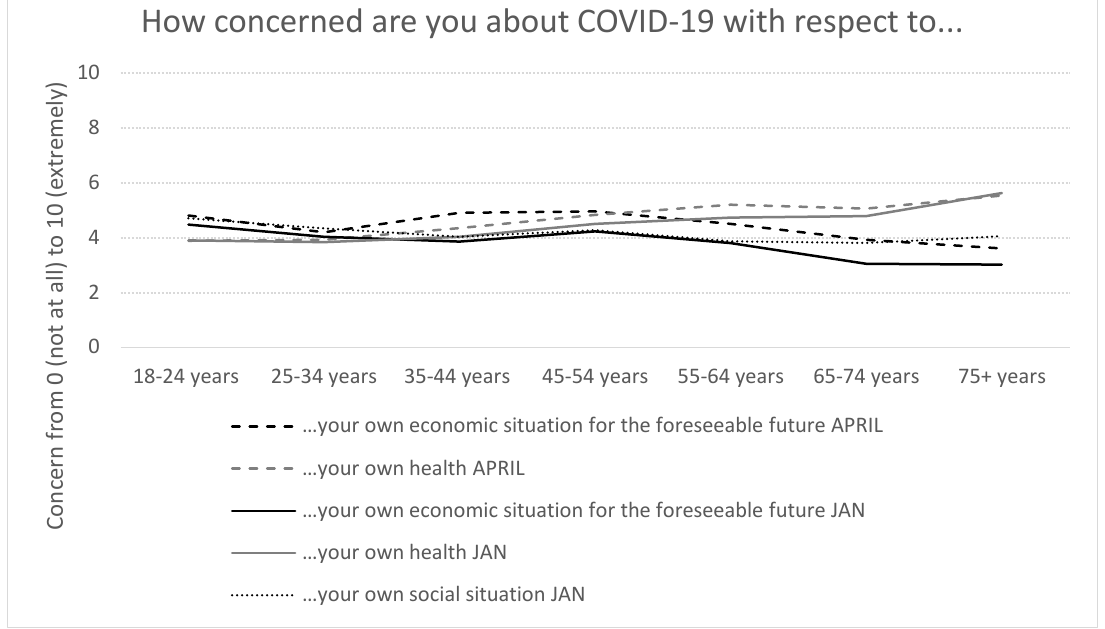
Figure 3: Mean concern about COVID-19 with respect to own economy, health and social life by age and time of